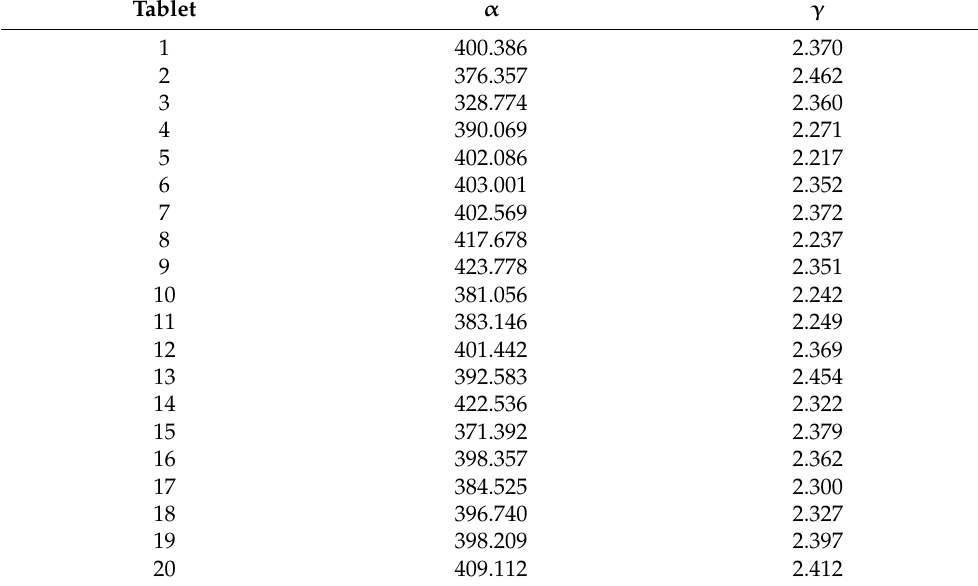
Table 2. Obtained α and γ values for each